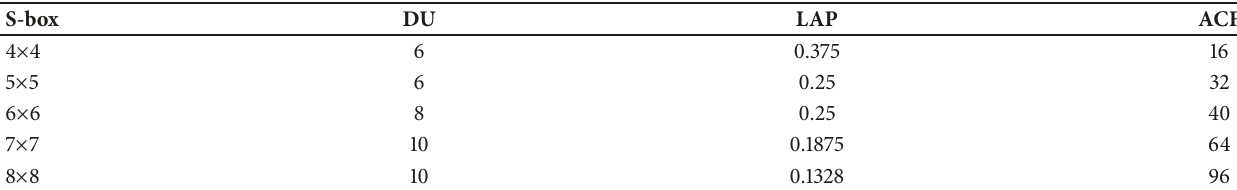
Table 16: The results of DU, LAP, and ACF for proposed bijective n × n S-boxes.